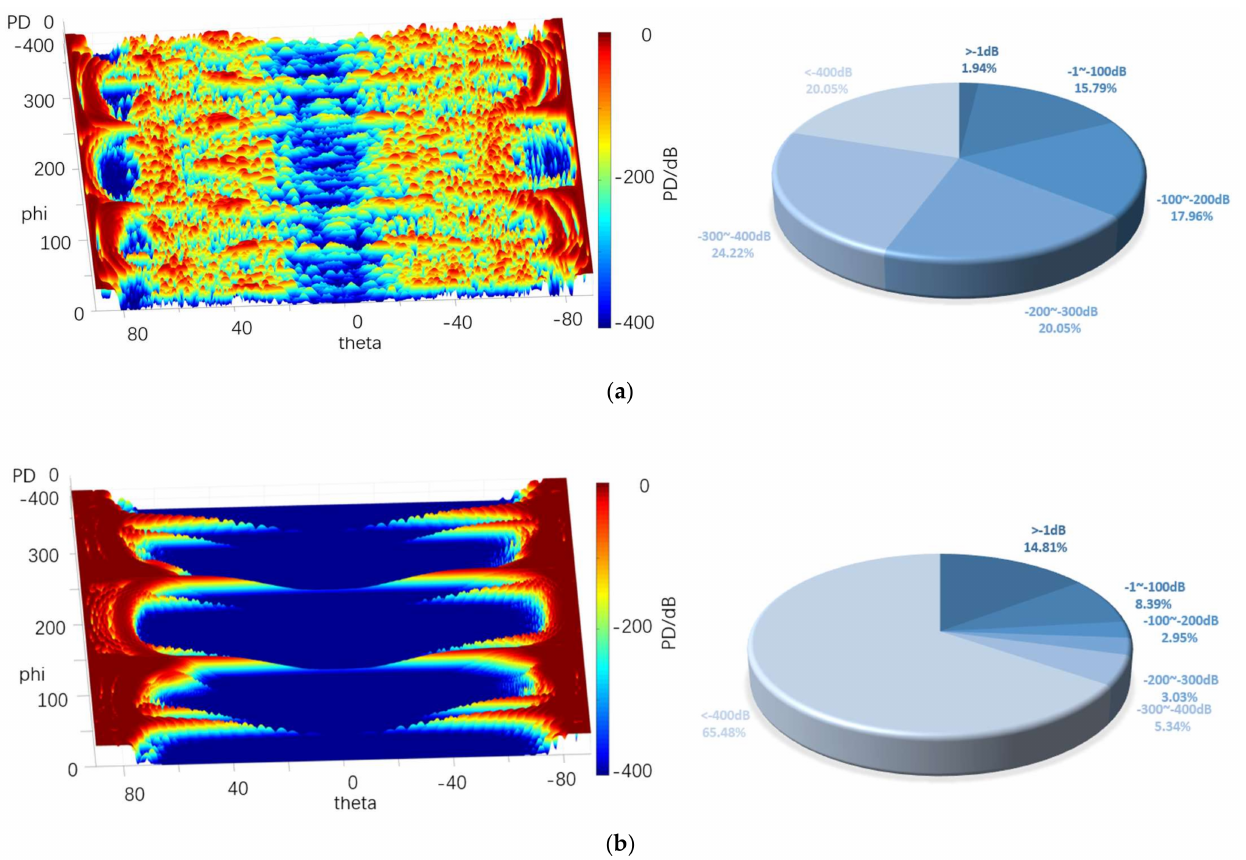
Figure 23. Probability distribution in the 4 π direction of 0.6 m 2 . ( a ) Quantum detection probability, ( b ) Probability of conventional